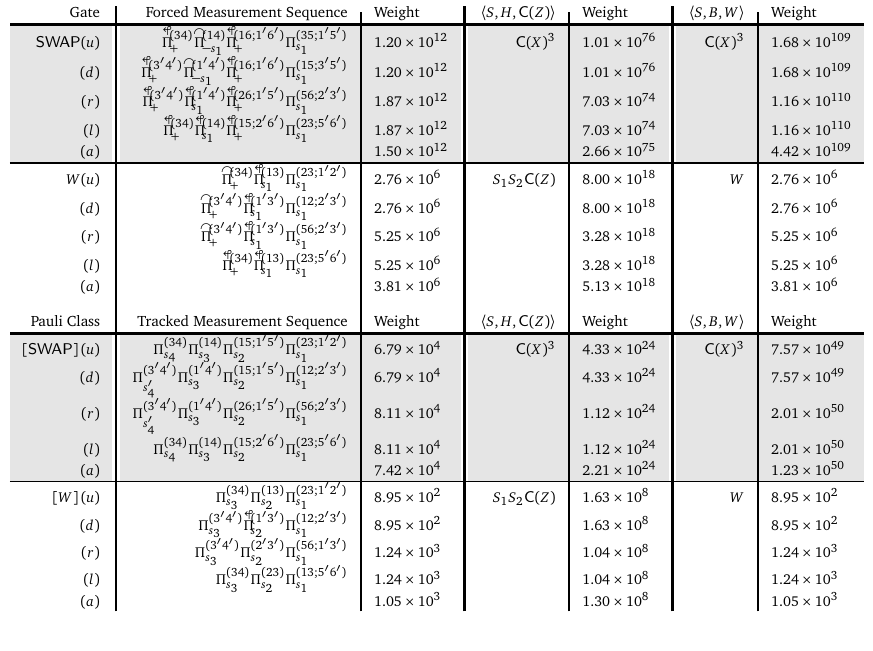
Table 12: Pauli gate corrections tracked for the corresponding SWAP gates imple- mented using Majorana-Pauli tracking methods. The implicit action on the two 1 − s (cid:48) ns (cid:48) 0 1 − sns 0 Π ( 34 ) Π ( 3 (cid:48) 4 (cid:48) ) ⊗ X ancillary qubits is X for sequences of length n . (When 2 2 s 0 s (cid:48) 0 there is not a final projector for one of the ancillary pairs, it is equavalent to there being a projector for that ancillary pair onto its initial projection channel,